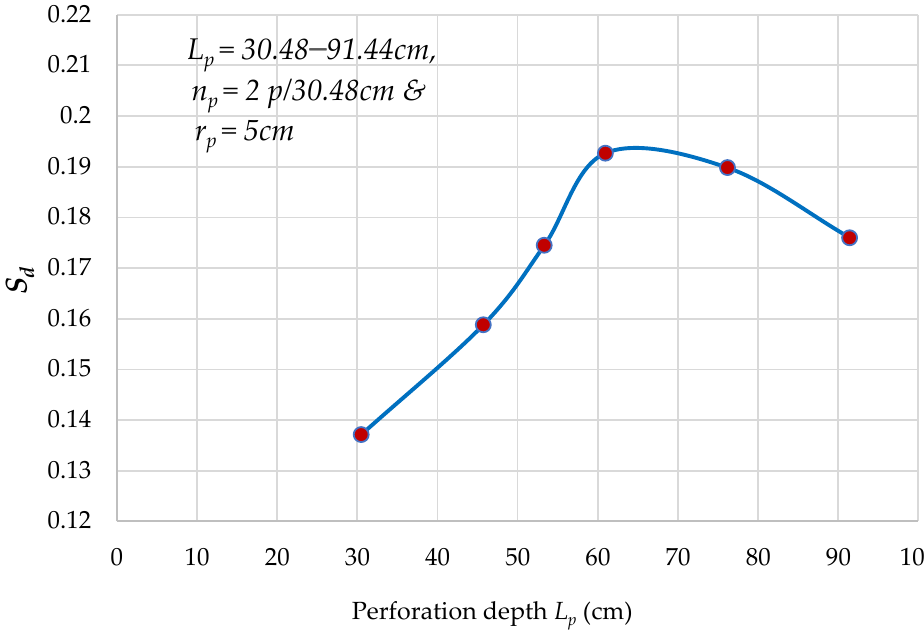
Figure 15. Difference in skin factor values for two perforation orientations with increasing perforation depth 𝐿 𝑝 (30.48–91.44 cm).